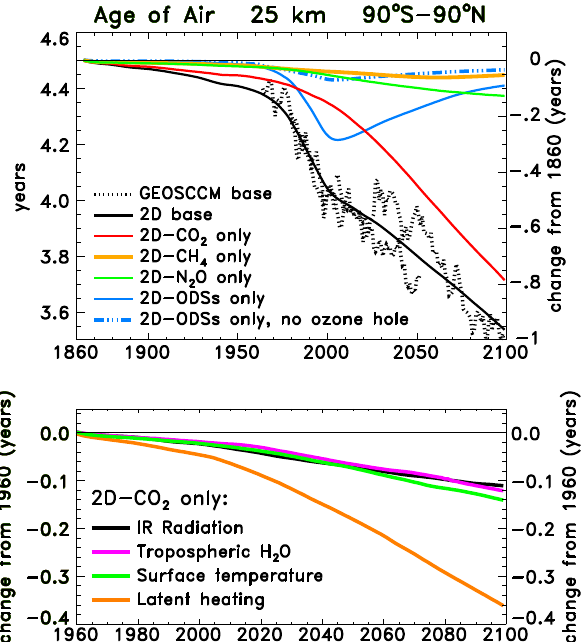
Fig. 12. Global and annually averaged age of air at 25km. (Top) Time series for 1860–2100 from the base simulations (all source gases varied time dependently) of the GEOSCCM (black dotted lines) and 2-D model (black solid lines). Also shown are 2-D simulations in which only certain source gases are varied time dependently as follows: CO 2 only (red solid); CH 4 only (orange solid); N 2 O only (green solid); and ODSs only (blue solid), with the other source gases fixed at 1850 levels. Also shown is a 2-D-ODS only simulation with all heterogeneous chemical reactions turned off so that no ozone hole is simulated (blue dashed-dotted). The right hand axis shows the change relative to 1860. The GEOSCCM time series is comprised of three simulations, which use somewhat different SSTs, for the time periods 1950–2004, 1971–2052, and 1996–2100 (the first 8–10yr of each simulation have been removed to allow for spin-up). For visual clarity and to account for a systematic offset between the models, we have added 0.3yr to the GEOSCCM curves. (Bottom) Time series for 1960–2100, relative to 1960, from several 2-D-CO 2 only simulations which use time dependent perturbations for the different processes as discussed in Fig. A1: IR radiation only (black solid); tropospheric H 2 O only (pink solid); surface temperature only (green solid); latent heating only (orange solid), with the other CO 2 effects fixed at 1960 levels. The sum of the curves in the bottom panel equals the 2-D-CO 2 only simulation (red curve) in the top panel. See text for details.